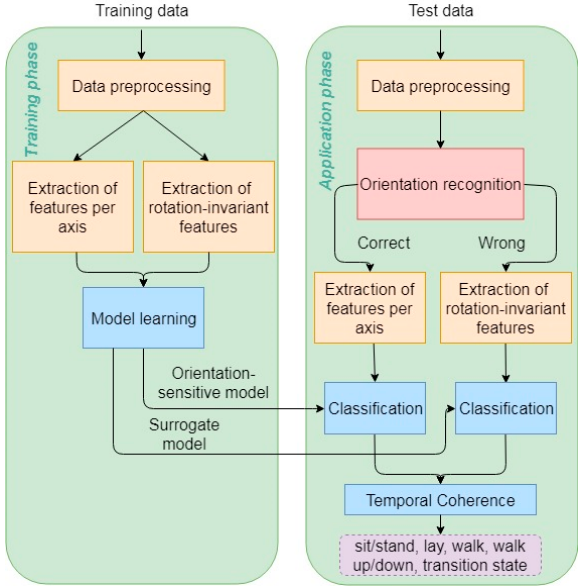
Figure 1. Pipeline of activity recognition methodology.